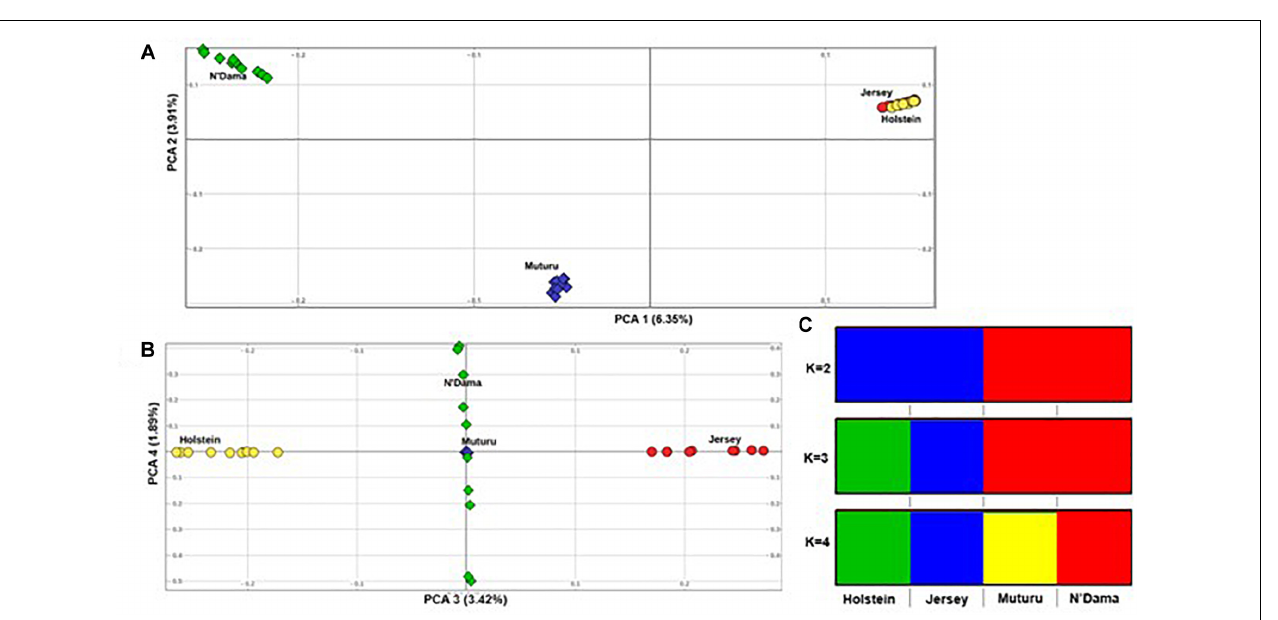
FIGURE 3 | Population structure of the four B. taurus breeds. (A) PC 1 versus PC 2, (B) PC 3 versus PC 4 and (C) Admixture analysis K =